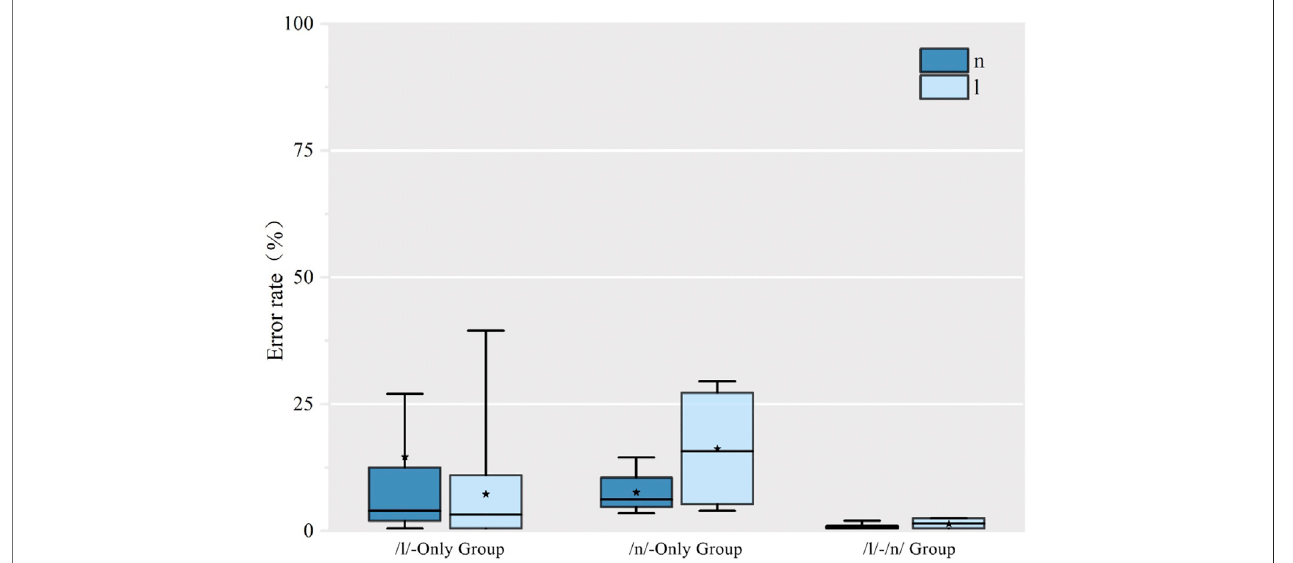
FIGURE 2 | Error rate of production of Standard Mandarin words with initial /n/ and /l/ by subjects ’ variety.